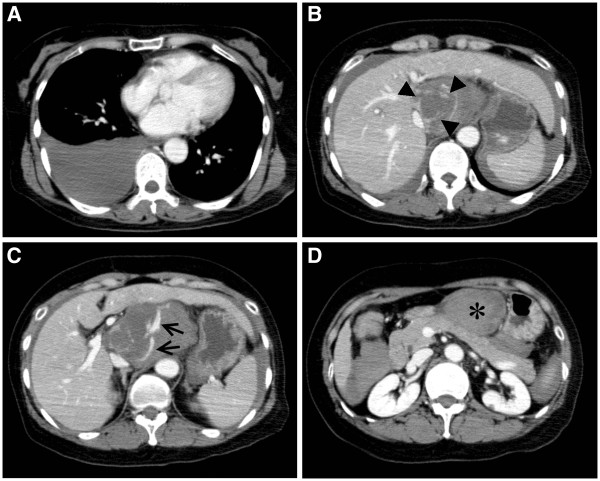
Chest and abdominal contrast-enhanced computed tomography. A) Right hemothorax. B) A ruptured tumor (arrowheads) and hemoperitoneum. C) Extravasation of the contrast medium (arrows). D) Hematoma inside the omental bursa (*).